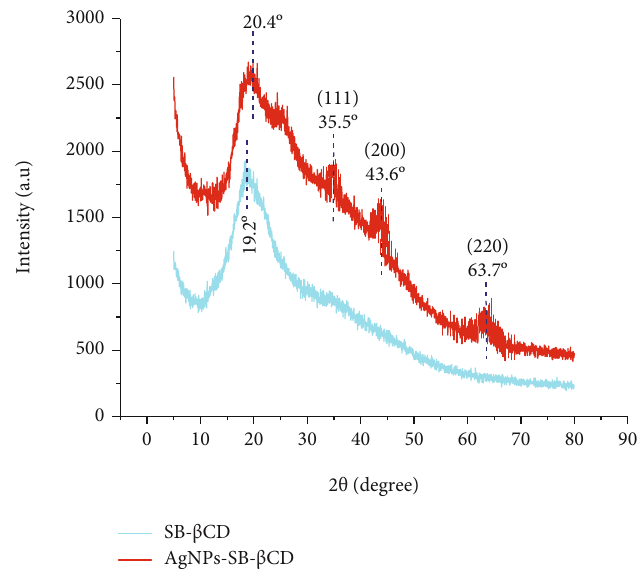
Figure 4: X-ray di ff raction pattern of SB- β CD polymers and AgNP-SB- β CD nanocomposites.